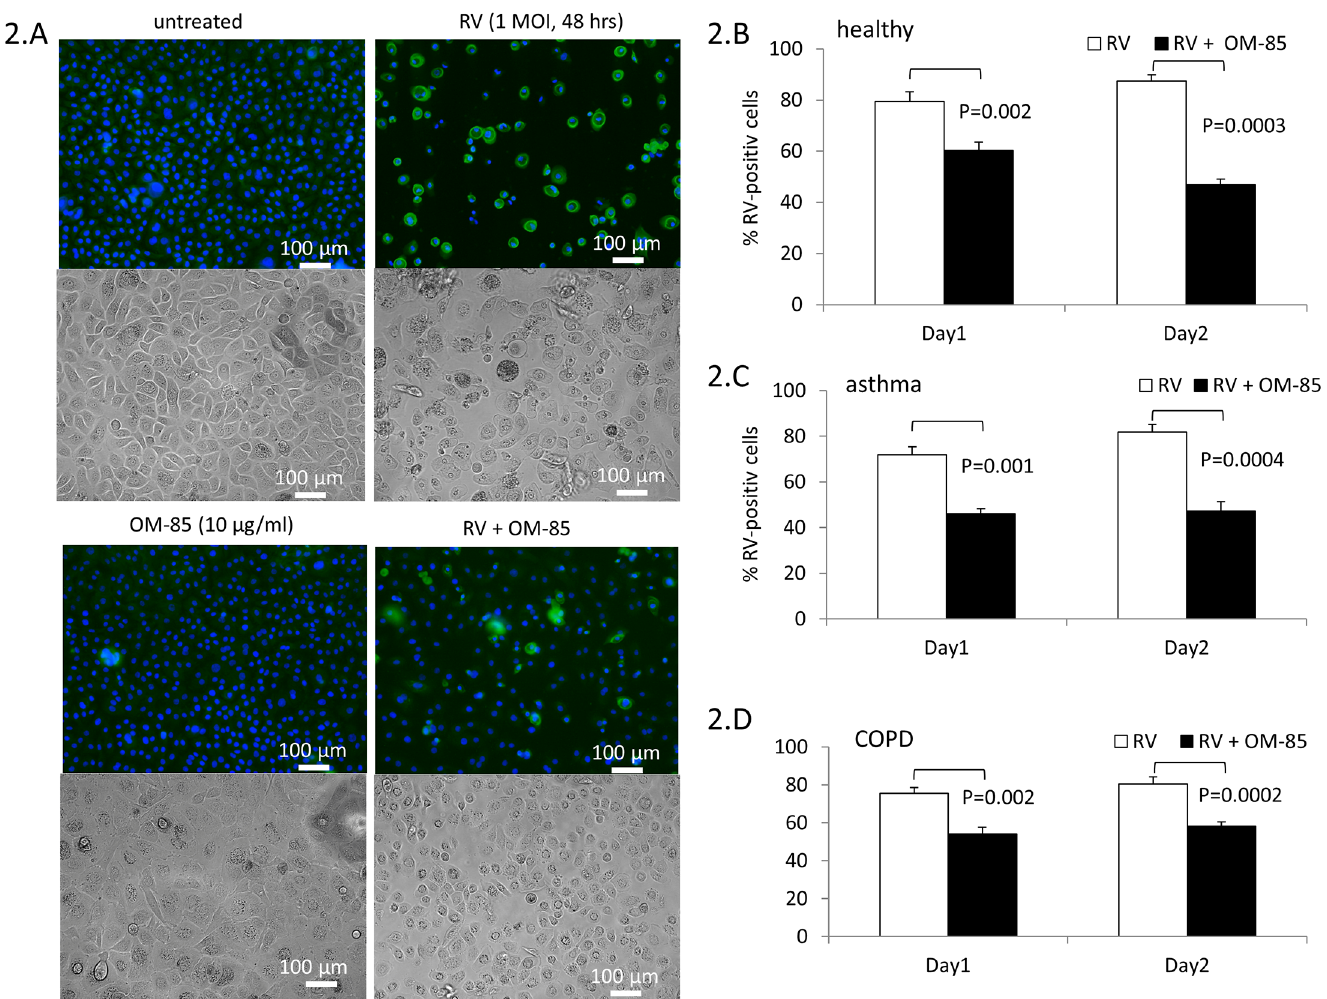
Fig 2. (A) Representative IF images for RV infection(green) in primary BEC; nucleiwere stainedfor cell countingby EVOS live cell staining kit (Thermofisher Scientific). Light microscopic images are depicted for the effect of OM-85 and RV infectionon BEC phenotype. (B-D) Quantitation of RV infectionof BEC by IF. BEC were pretreatedfor 24 or 48 hrs with OM-85 (10 μ g/ml). Bars represent mean ± SEMof RV positive BEC derived from: non- asthma, non-COPD controls (n = 8), (C) COPD (n = 10) and (D) asthma (n = 9). Statistics were performed with pairedStudent’s t-test,